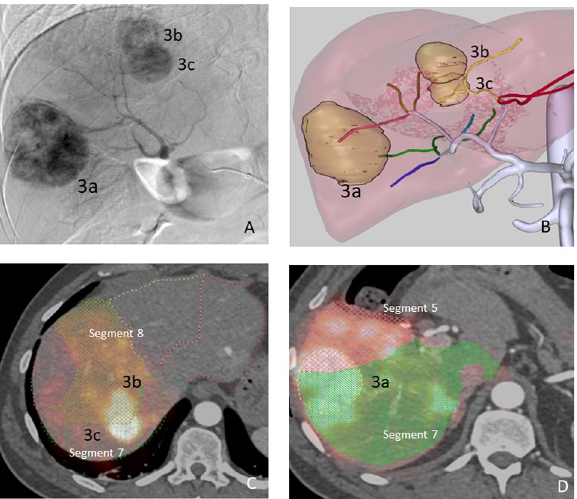
Figure 4. Patient 3. Multinodular HCC in the arteriography study ( A ). MeVis study showing arterial liver segment territories ( B ) as well as tumor nodules (3a to 3c). Using the imported MeVis liver segment contours on co-registered 90 Y PET-angioCT (E and D), it is posible to define that tumor 3b is feeded by segment 8 artery, 3C by segment 7 and 8 arteries and tumor 3a by segment 5 and 7